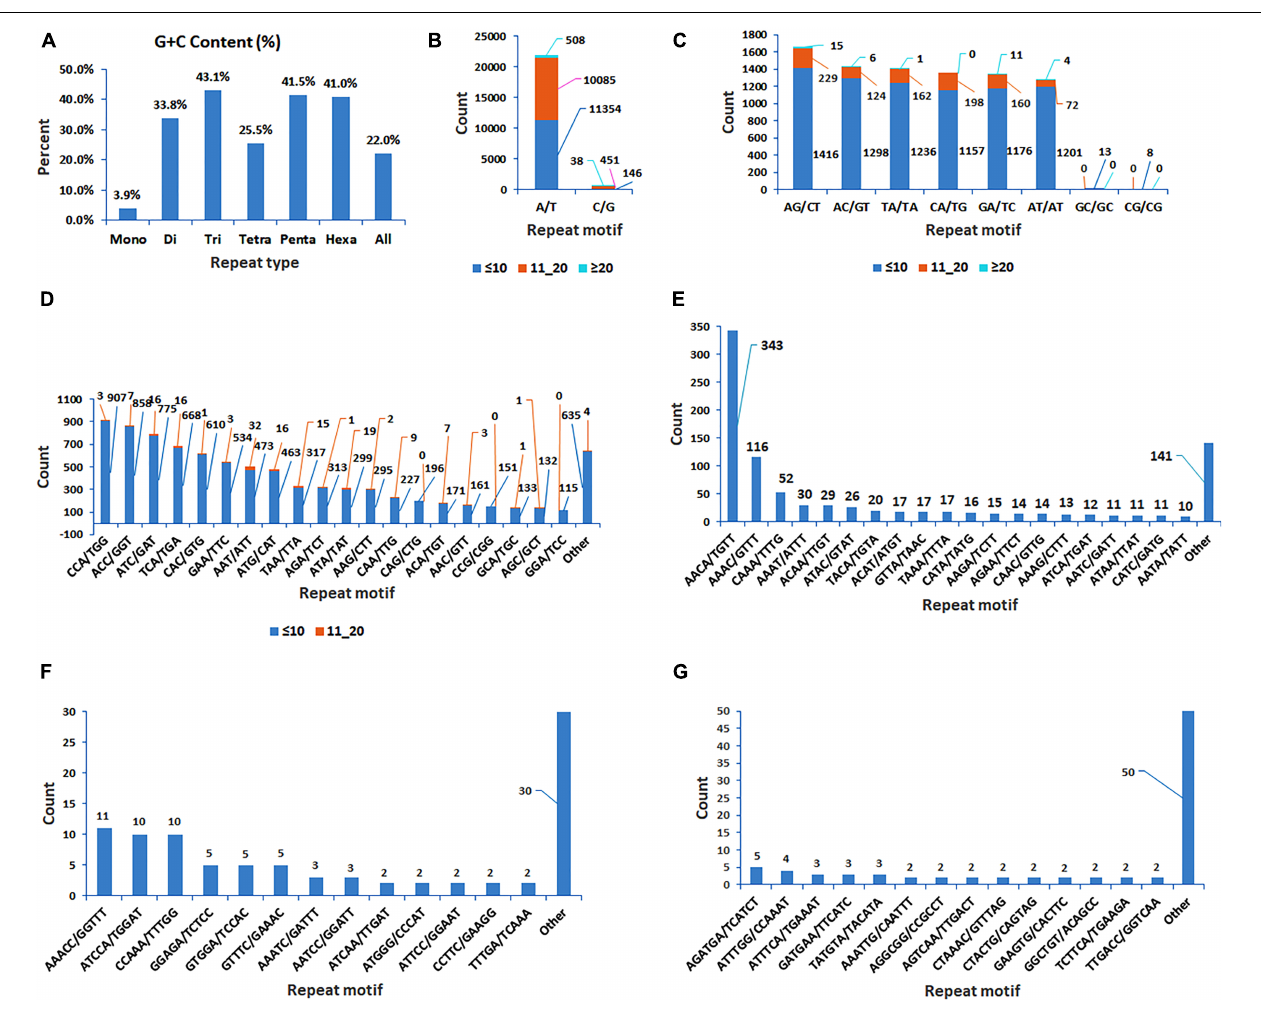
FIGURE 2 | Bar graphs displaying the G + C content of mono, di, tri, tetra, penta and hexanucleotide repeat SSRs, and all SSRs together (A) ; and the number of classified repeat types considering sequence complementarity) for mono, di, tri, tetra, penta and hexanucleotide repeat SSRs, which were grouped based on the number of times a repeat motif was repeated (three groups for mono and dinucleotide repeats, two groups for trinucleotide repeats, and one group for each of tetra, penta and hexanucleotide repeats) (B–G)